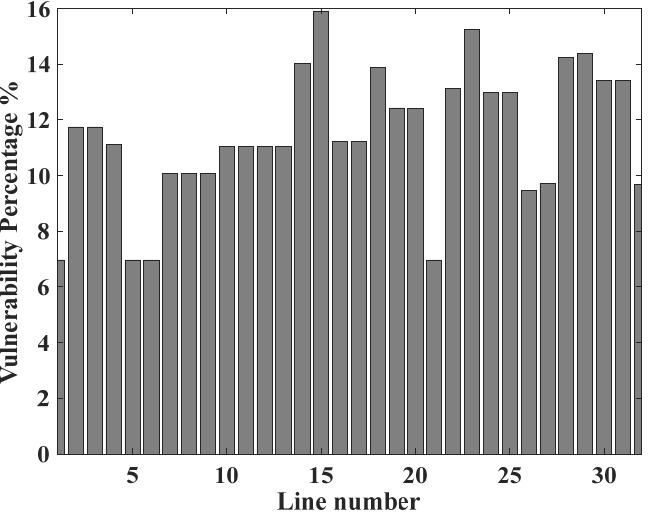
Figure 8. Illustration of the vulnerability analysis of the lines for strategy 1.